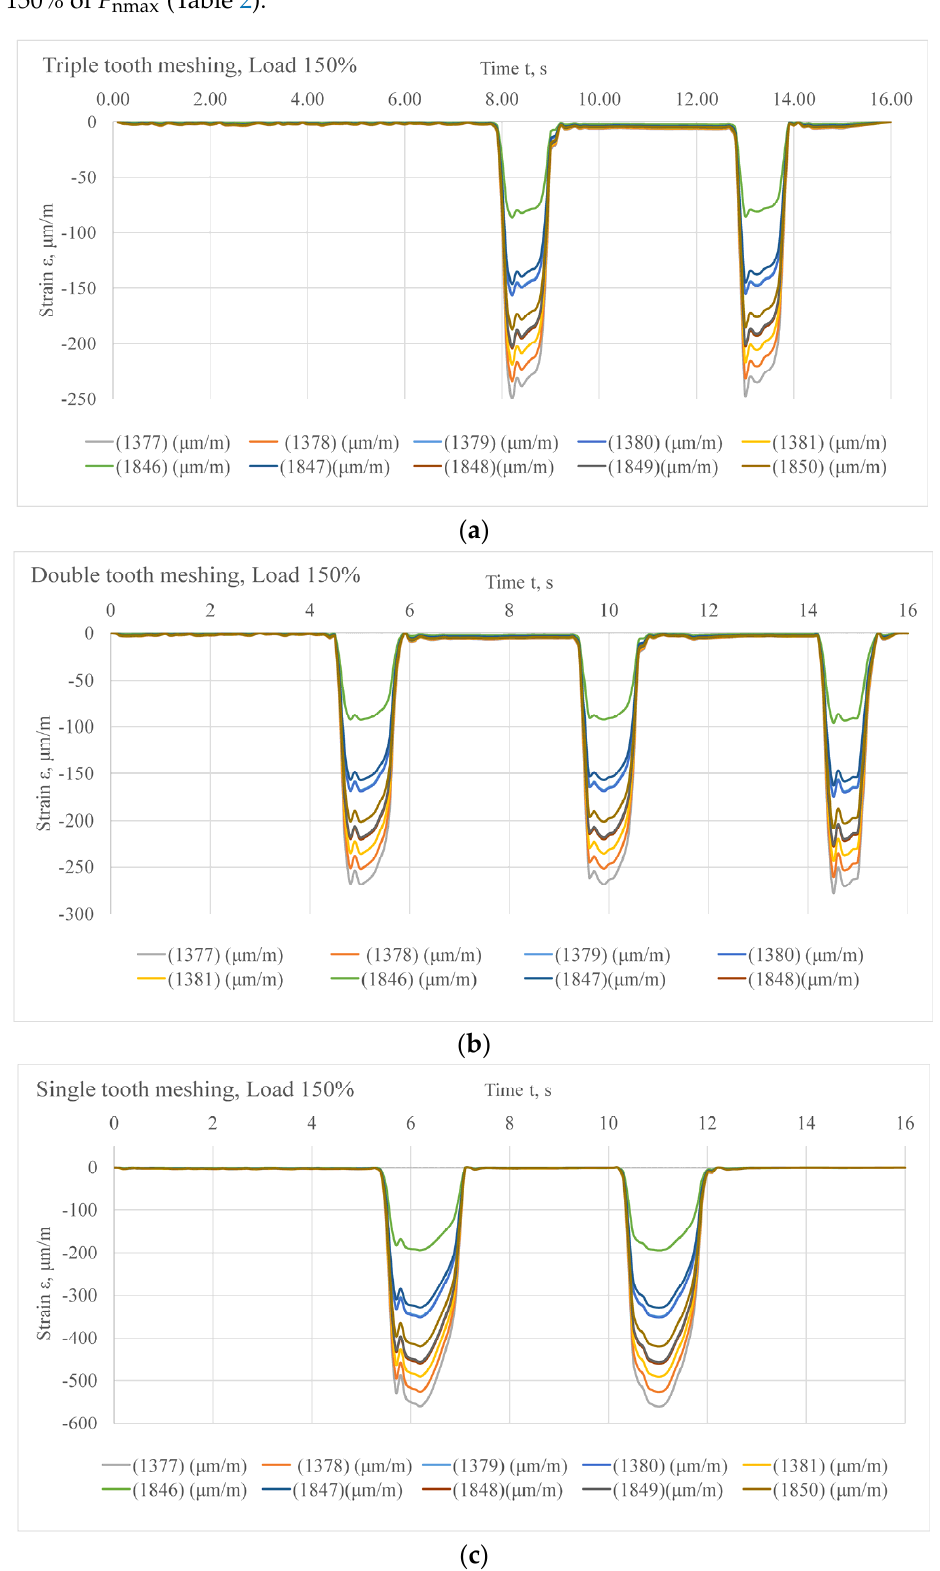
Figure 10. Von Mises strains in the time domain for the external load of 150% F Nmax for: ( a ) triple − tooth meshing, ( b ) double − tooth meshing, and ( c ) single − tooth meshing. The lowest stress value on the cycloid disc occurs in the case of the triple-tooth mesh- ing of the cycloid disc and the ring gear ( σ = 338 MPa). About 7% higher stresses occur at the double-tooth meshing compared to the triple-tooth meshing, while about 224% higher stresses occur at the single-tooth meshing compared to the triple-tooth meshing. At the single-tooth meshing and the load of 150% of F Nmax , the stresses that occur are close to the yield stress value, but this is only for very short time intervals.